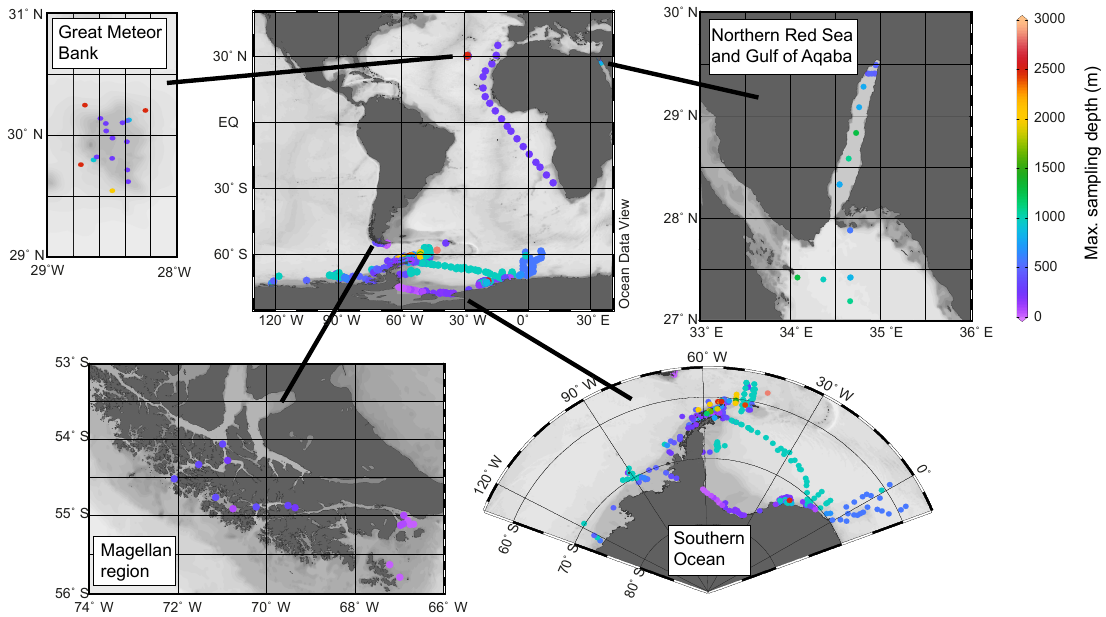
Figure 1. Overview of all stations and sampling regions, including the maximum sampling depths (colour scale bar) of the data